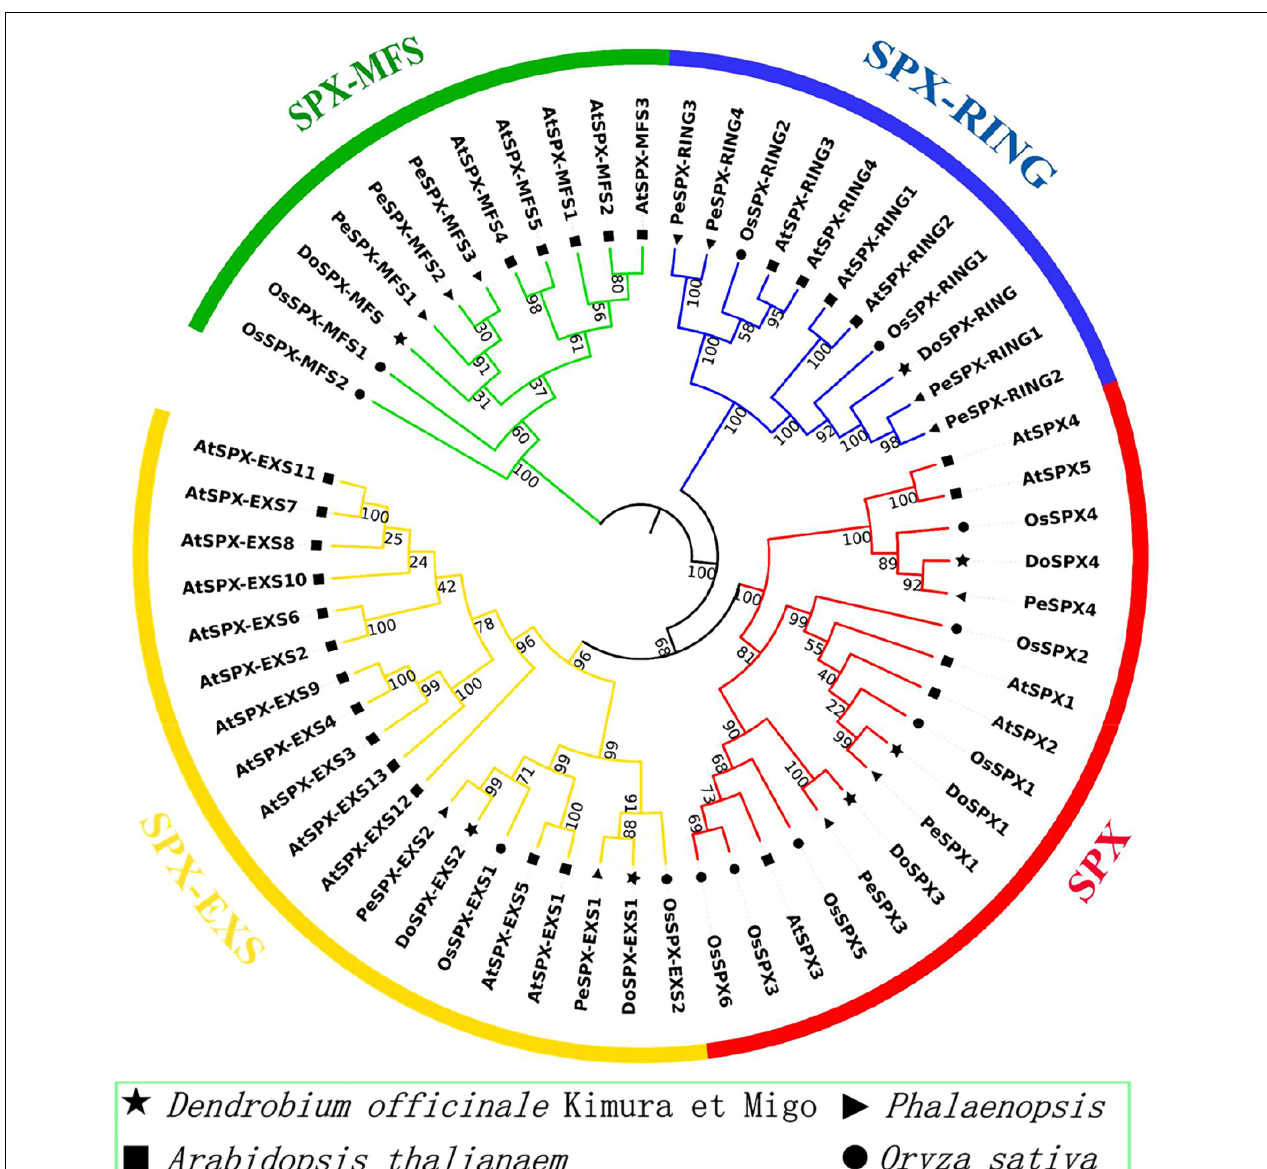
FIGURE 1 | Phylogenetic analysis of SPX proteins in Dendrobium officinale , Phalaenopsis equestris , Oryza sativa , and Arabidopsis thaliana . The neighbor-joining (NJ) tree was created with 9 D. officinale , 12 P. equestris , 12 O. sativa , and 27 A. thaliana SPX protein sequences.